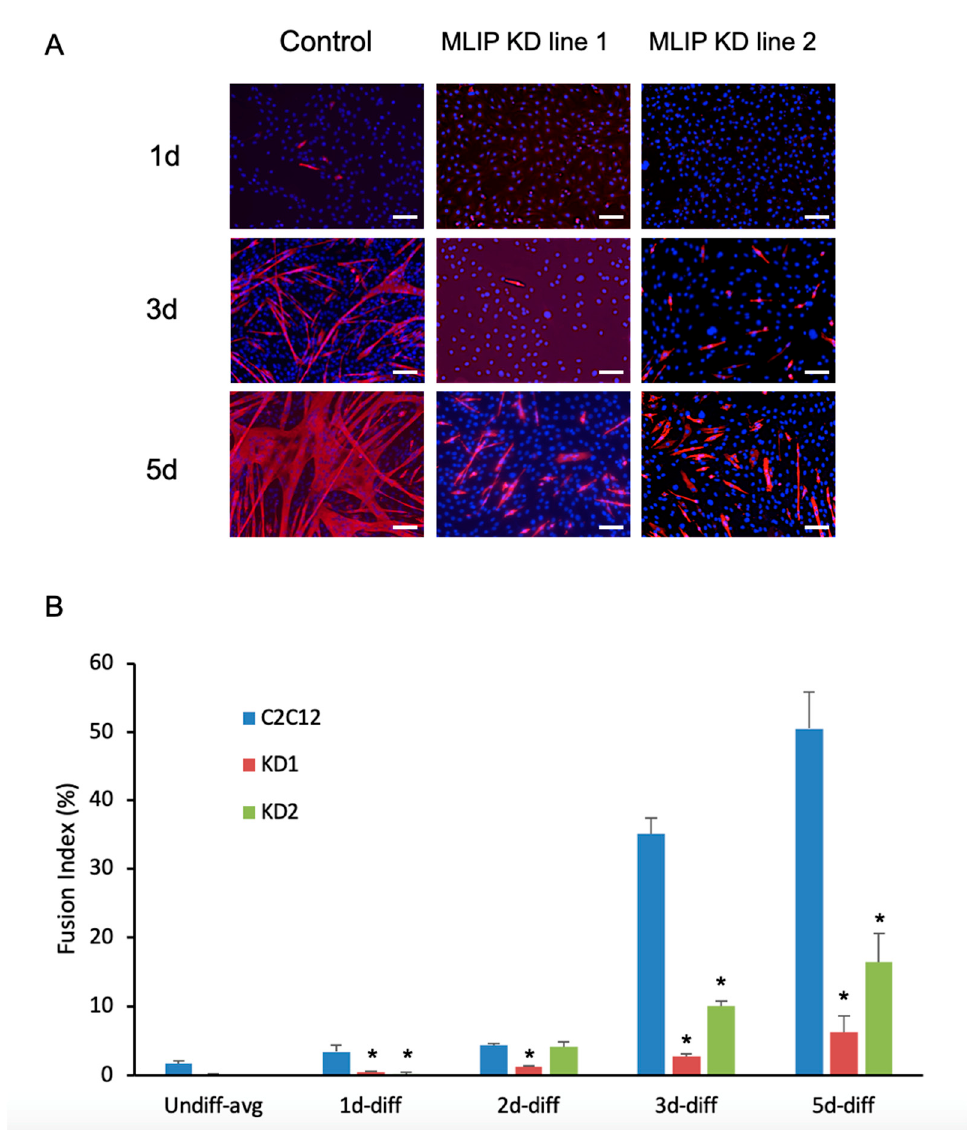
Figure 4. Mlip is required for normal myotube fusion and formation. ( A ) Indirect immunofluorescence of myosin heavy chain expression during C 2 C 12 differentiation in the normal or in MLIP -depleted C2C12 myoblasts. Nuclei were stained with DAPI. 10 x magnification; Scale bar = 50 uM ( B ) Fusion index calculated as the fraction of total nuclei present inside myotubes (MyHC positive cells) after 0, 1, 2, 3 and 5 days of differentiation. The data represent the pooling of 3 independent differentiations with * = p < 0.001 vs. control. Control cells were generated using a validated non-silencing negative control.